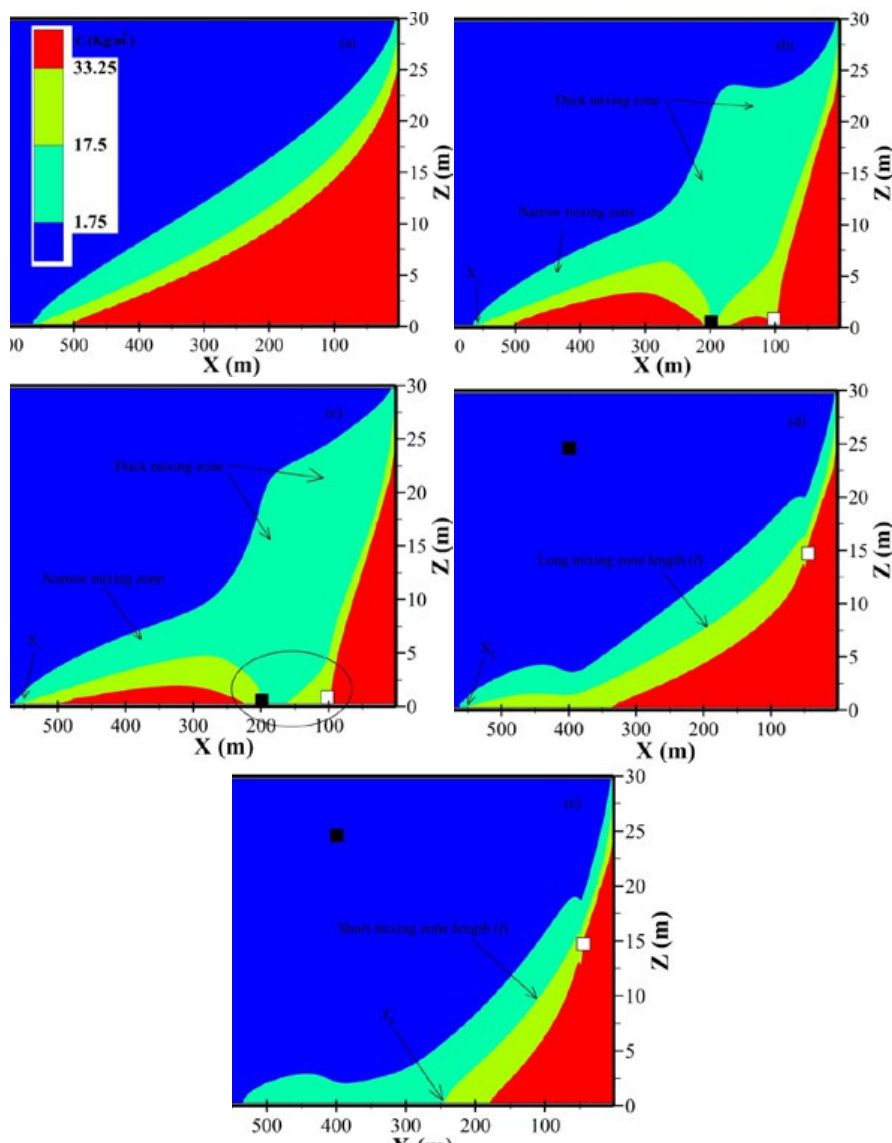
Fig. 5: (a) steady state SWI before ADR, (b), (c) respectively after 10 and 20 years of transient ADR modeling of scenario 8, (d) and (e) respectively after 10 and 25 years of transient ADR modeling of scenario 15. Solid black and white rectangular indicate recharge and abstraction wells respectively